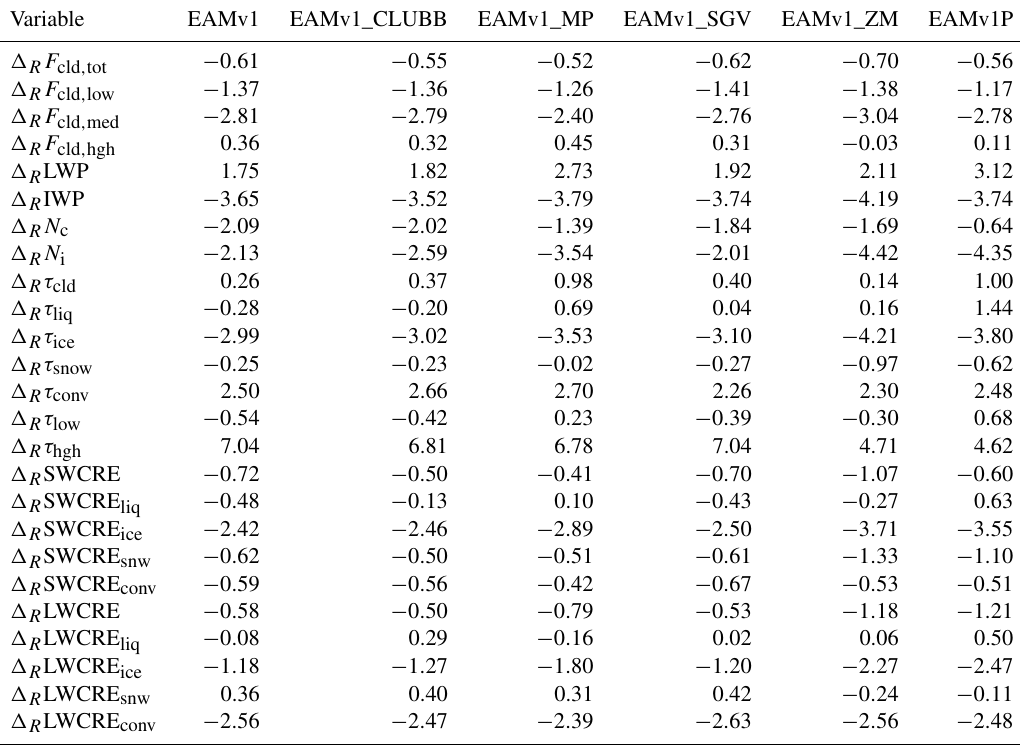
Figure 19. Zonal mean of (a) total cloud feedback, (b) cloud optical depth feedback, (c) cloud amount feedback, and (d) cloud altitude feedback. Table 11. The same as Table 6 but showing the change in cloud properties induced by surface warming relative to their pre-industrial values (unit = %K − 1 ). Variables are defined in Table